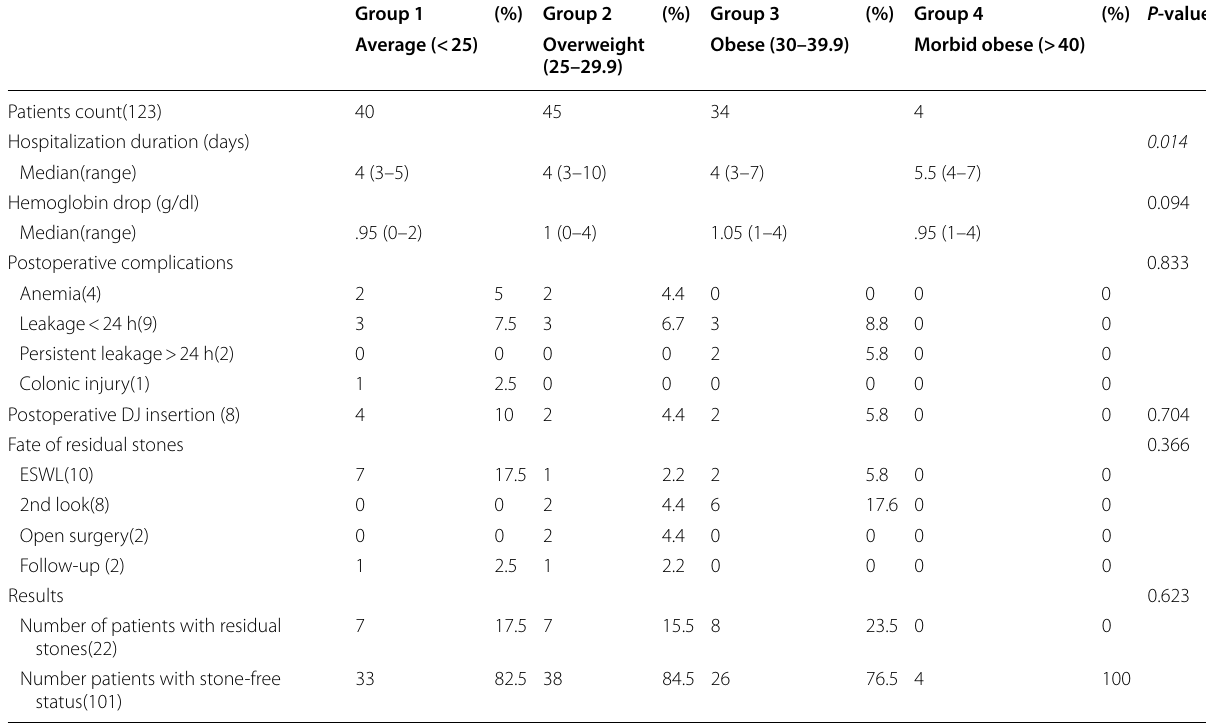
Table 3 Analysis of postoperative variables